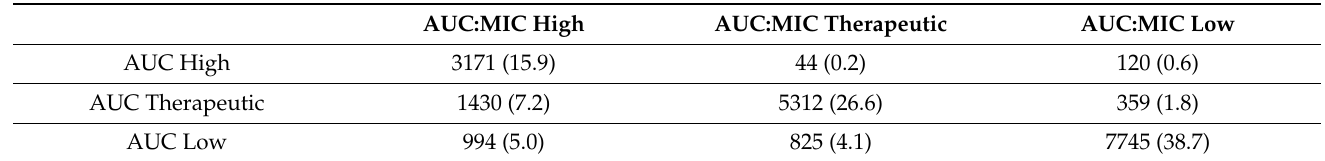
Figure 5. Example of one of five (n = 20,000) Monte Carlo simulations—random pairing of AUC 24 ( X − axis, values from [31]) to an MIC value to calculate expected AUC 24 :MIC ( Y − axis, values from [32]). Correlation in this simulation R 2 = 0.484. β = 1.211 See text for details. Table 4. Agreement of dosing assessments by AUC versus AUC 24 :MIC number, (percentage of total) of Monte Carlo Simulation—see text for